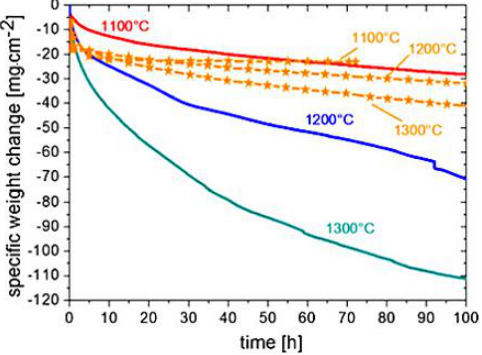
Figure 11. Specific weight change vs. time for the Ti-doped (continuous curves) and Ti-free (discontinuous curves) Mo-9Si-8B composites oxidized at various temperatures. Reproduced with permission [58]. Copyright 2013 Springer Nature.